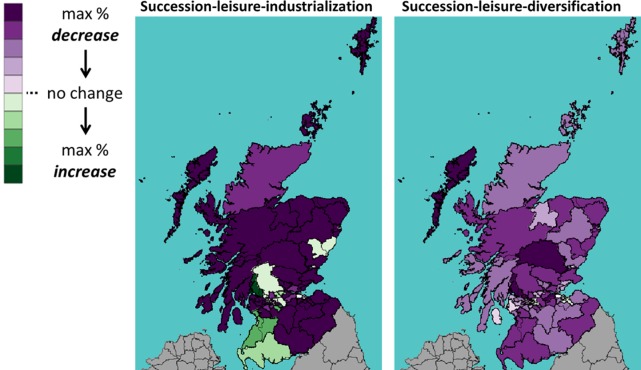
Percentage change in the number of all cattle under UTL scenario.